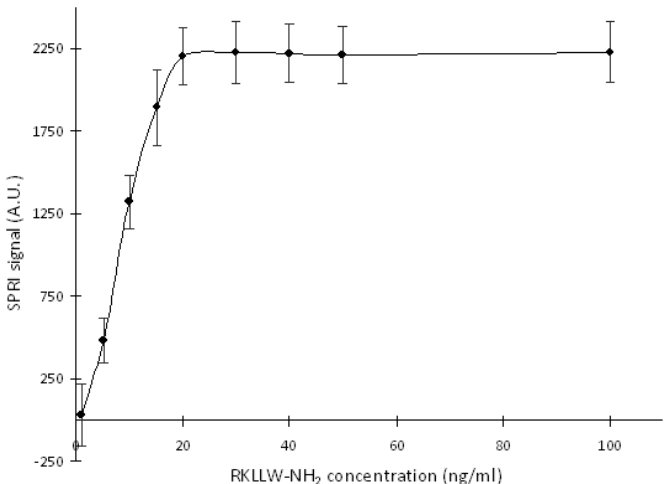
Figure 1. The dependence of the Surface Plasmon Resonance Imaging (SPRI) signal (A.U.) on RKLLW-NH 2 concentration. Cathepsin L (CTSL) standard solution concentration is 10.00 ng/mL; pH = 4.5. Error bars are the standard deviation of the average SPRI signal of each standard solution determined from twelve independent measurements.